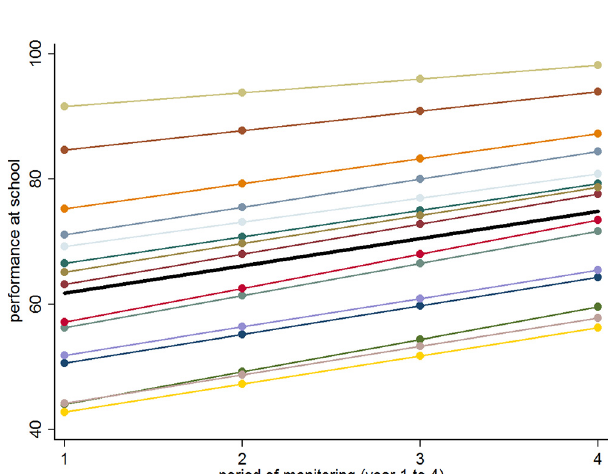
Figure 3. Temporal evolution